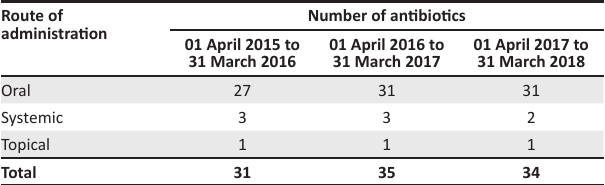
TABLE 2: Indications of the five most commonly procured antibiotics which are cited (verbatim) from the Standard Treatment Guidelines. 26 Antibiotic Indication(s)